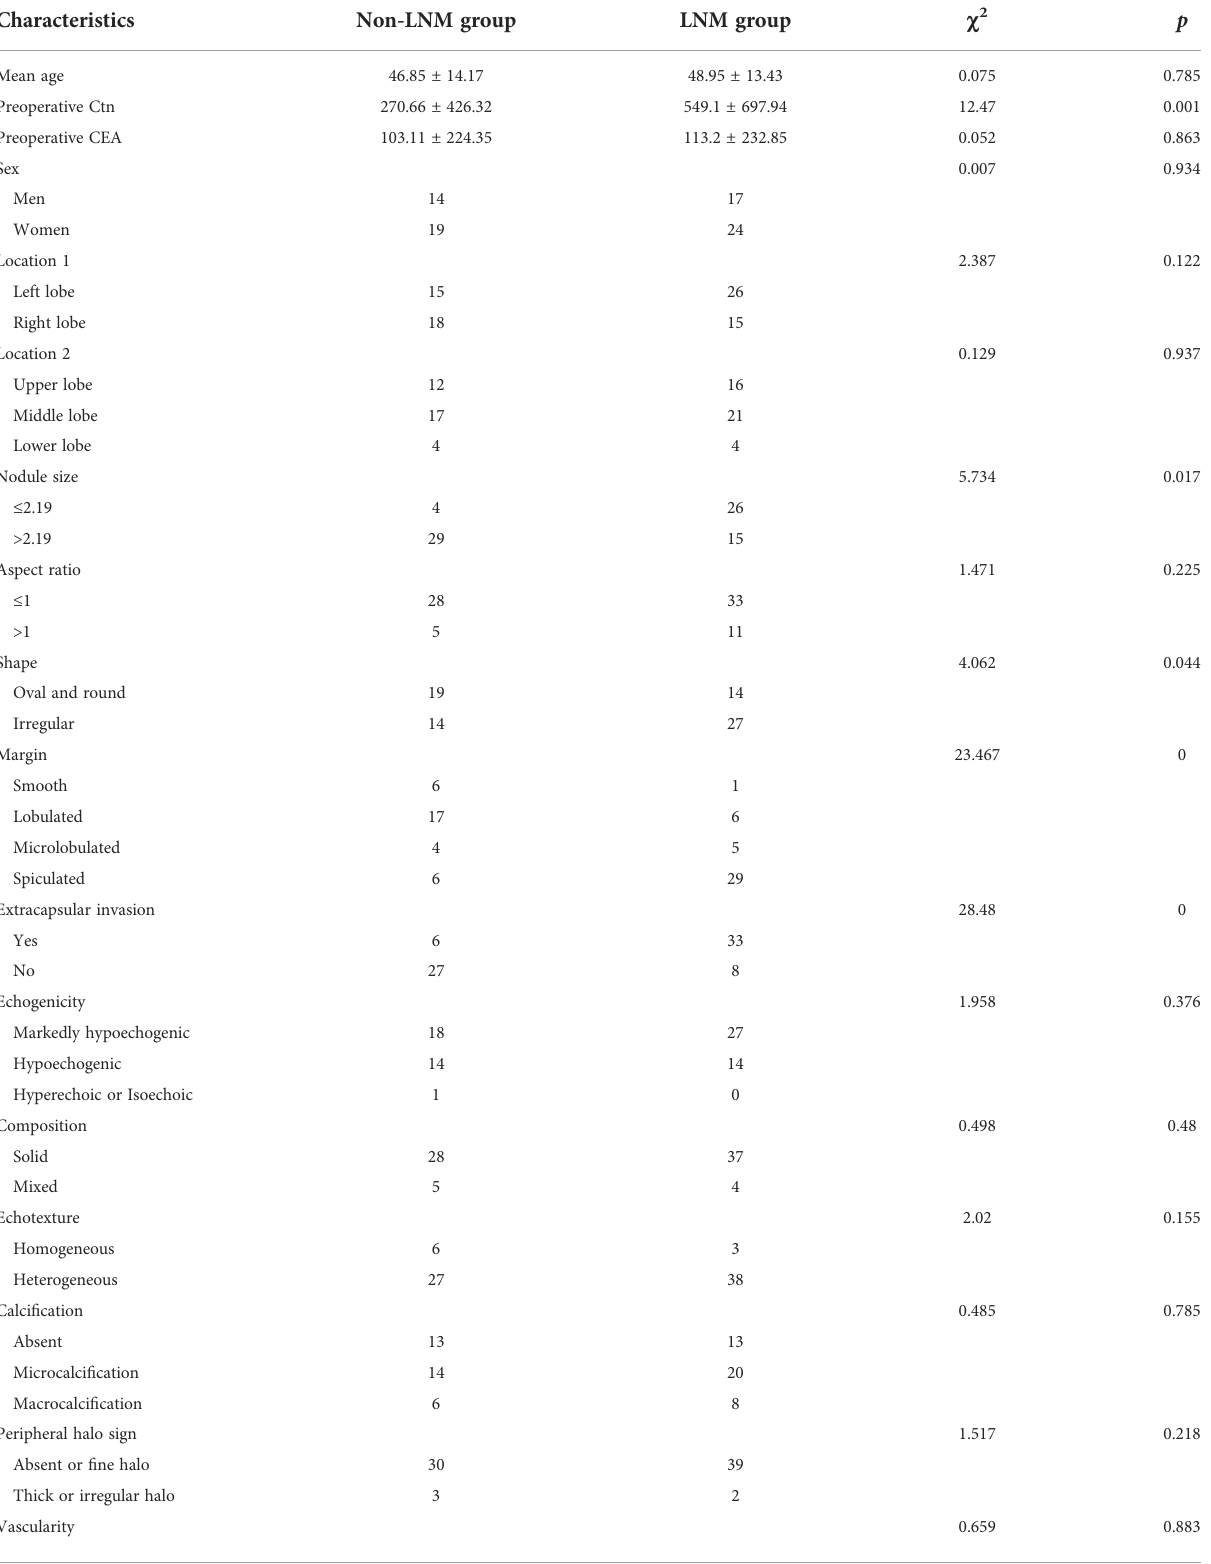
TABLE 1 Clinical and US imaging characteristics of